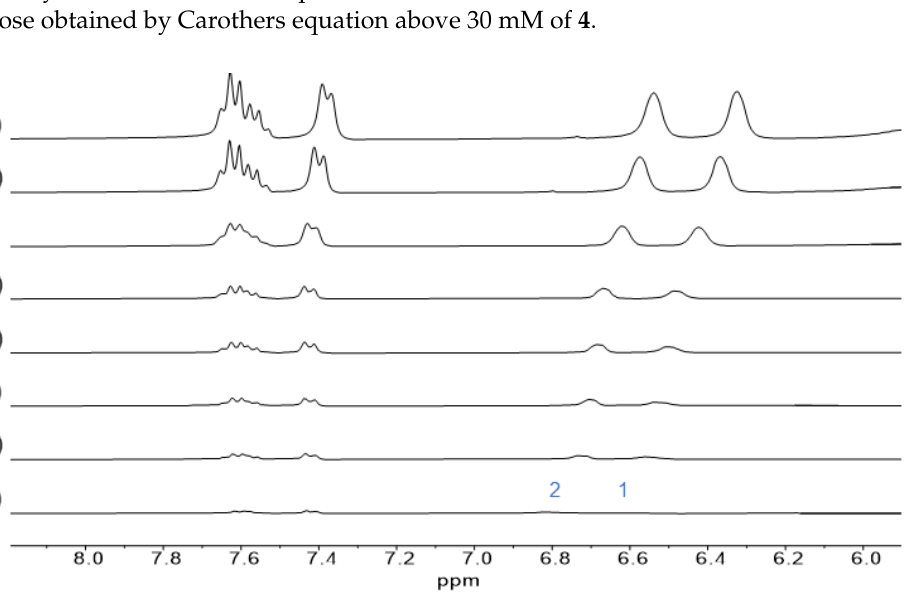
Figure 5. Partial NMR spectra (300 MHz, D 2 O) of 13a at various concentrations. Highlighted signals were used for the calculation of the degree of polymerization. Concentrations: ( a ) 1 mM, ( b ) 2 mM, ( c ) 3 mM, ( d ) 4 mM, ( e ) 5 mM, ( f ) 10 mM, ( g ) 15 mM, and ( h ) 20 mM.